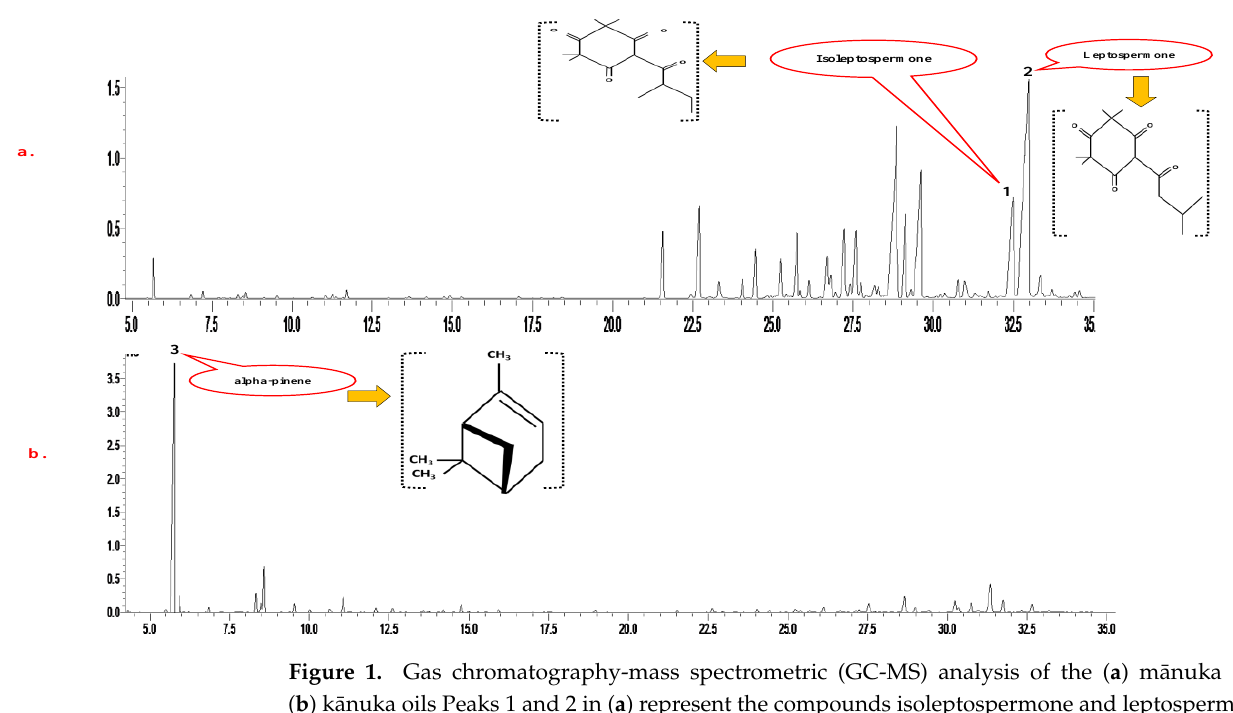
Figure 1. Gas chromatography-mass spectrometric (GC-MS) analysis of the ( a ) mānuka and ( b ) kānuka oils Peaks 1 and 2 in ( a ) represent the compounds isoleptospermone and leptospermone in kānuka oil 3, respectively. Peak 3 in ( b ) represents the presence of the compound alpha-pinene as a major compound in kānuka oil .